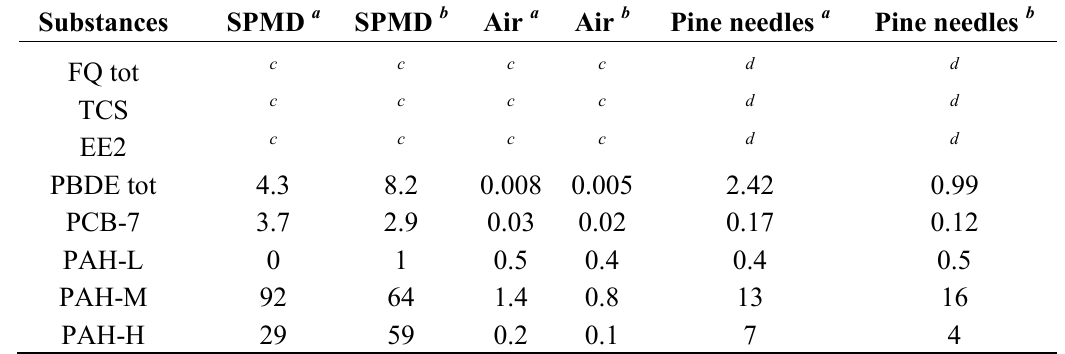
a Furuberget location, see Table 4; b Bäcksjön location, see Table 4; c Humic layer samples; d Fertilized site; e Mineral soil sample; f Not analyzed; g Below limits of quantification; h Results of the additional sampling conducted October 2011. Table 3. The absolute amount (in ng) in the passive samplers (SPMD), levels in